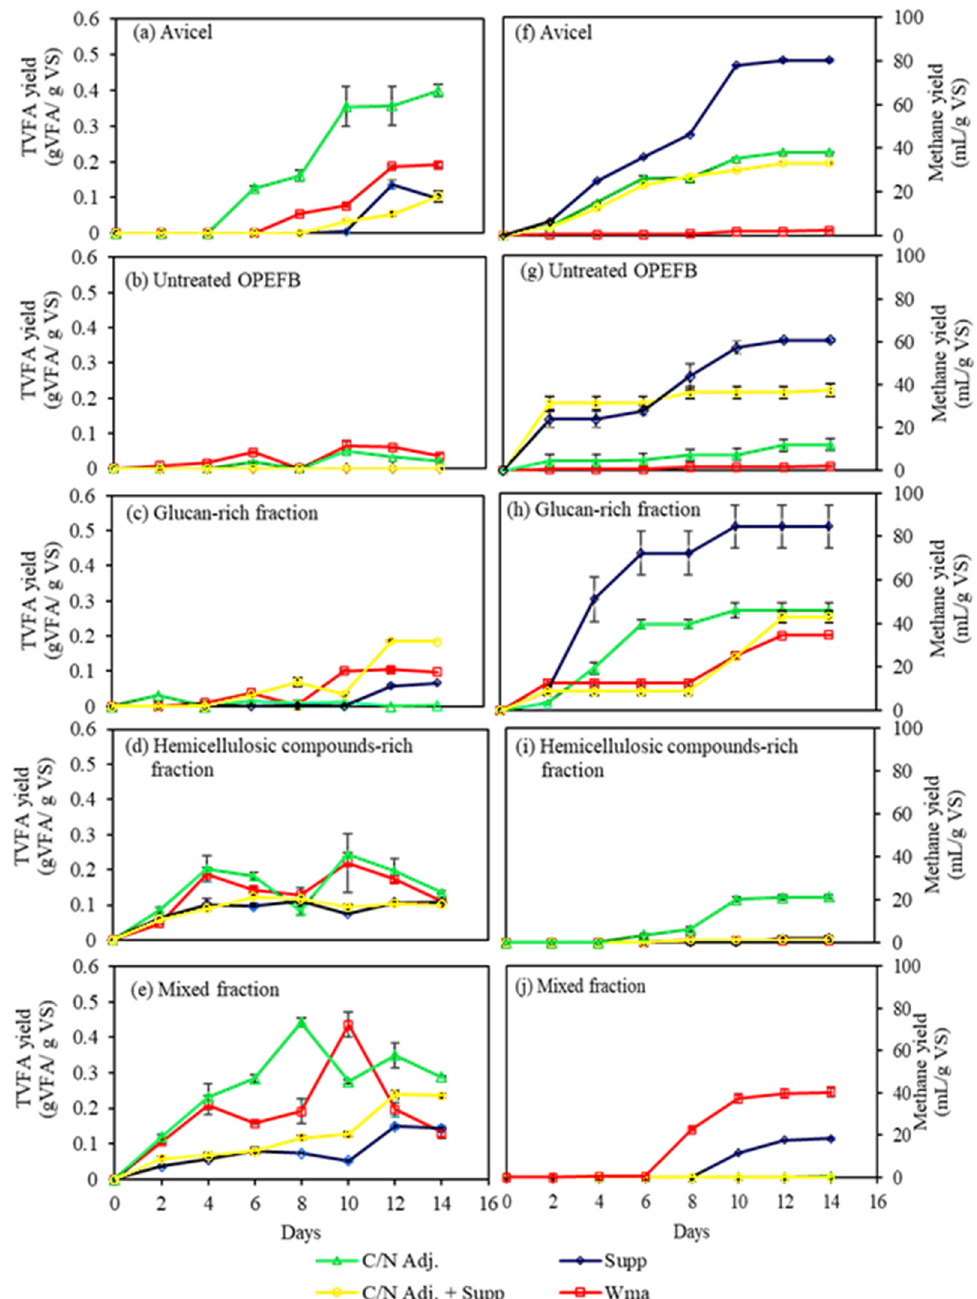
Figure 1. Total volatile fatty acid (TVFA) ( a – e ) and methane gas ( f – j ) yield during batch acidogenic fermentation of Avicel, untreated OPEFB, glucan-rich fraction, hemicellulosic compounds-rich fraction, and mixed fraction with or without C/N ratio adjustment and medium supplementation. The experiments were done in triplicate. Wma: without medium adjustment; C/N adj: C/N ratio adjustment; Sup: supplementation with trace